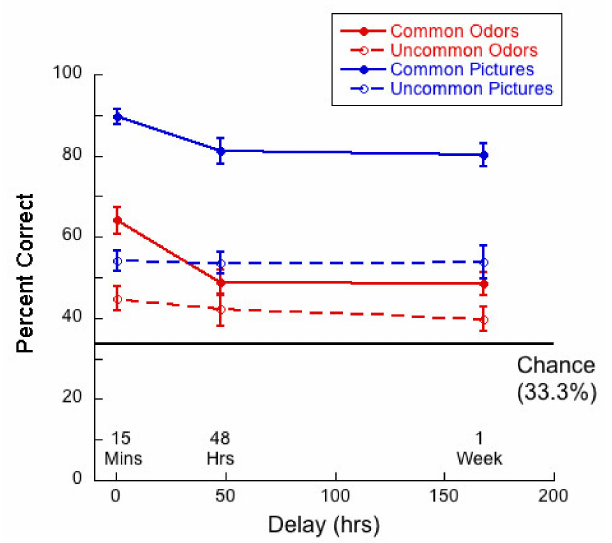
Figure 2. Percent correct as a function of delay for each of the four test conditions. Chance perfor- mance is 33.33% because participants could make a “neither” response. Here and in all figures, error bars reflect ± standard error of the mean. There were 27 participants in the 15-min delay condition, 25 at 48 h and 27 at 1